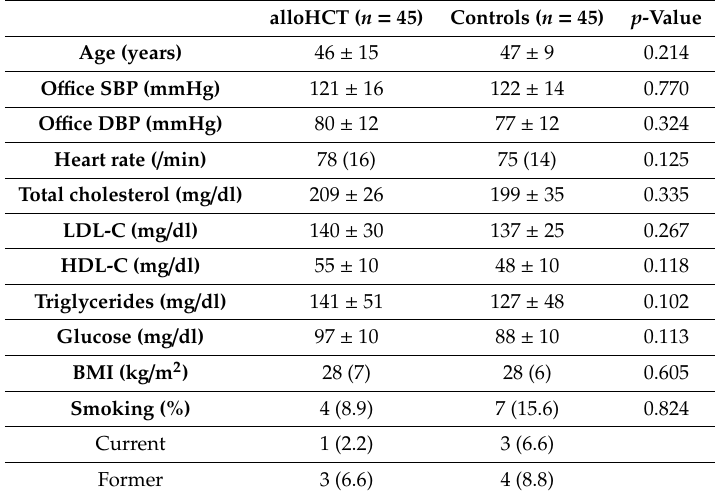
Table 2. Baseline characteristics of cardiovascular disease in alloHCT survivors and matched